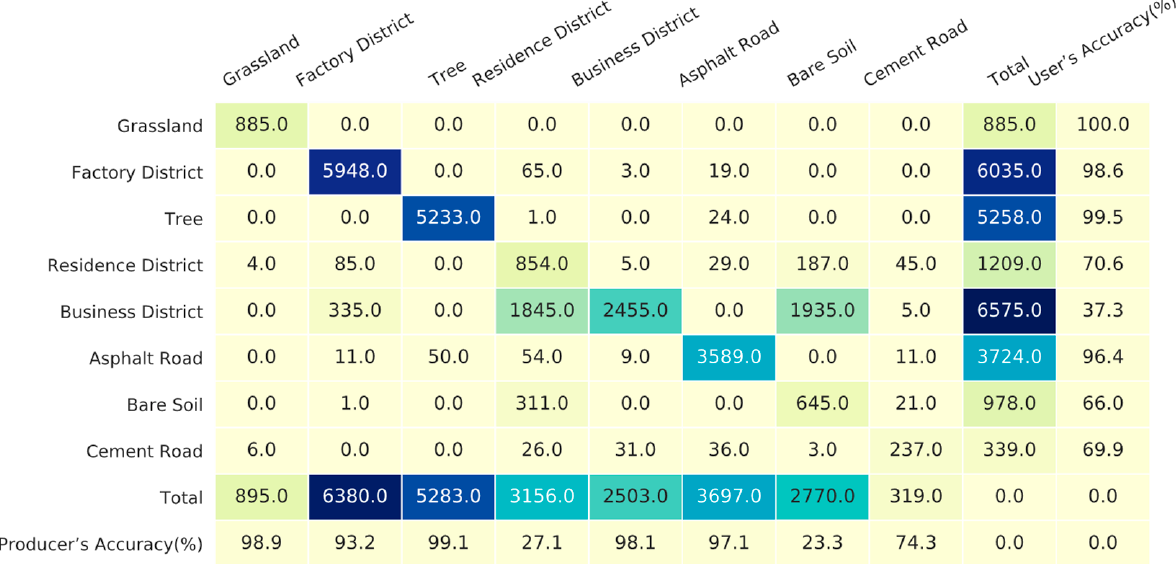
Figure 7. Confusion matrix of the classification results obtained when one set of 32-angle images was employed as the input data.